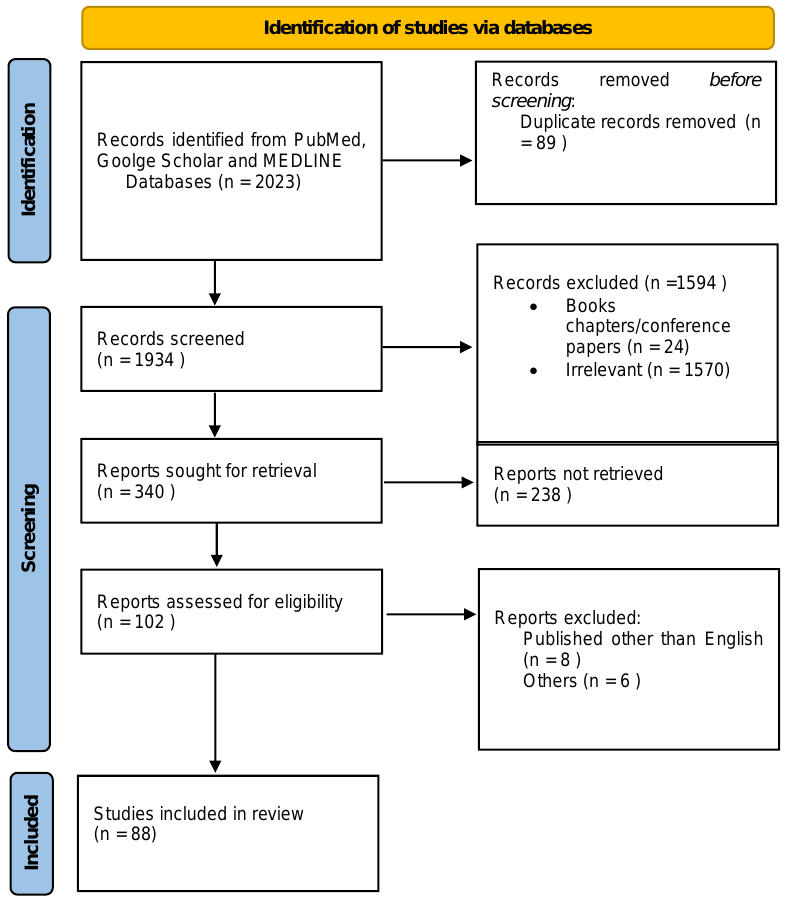
Figure 2. PRISMA flowchart showing the selection process of articles retrieved from different web sources.